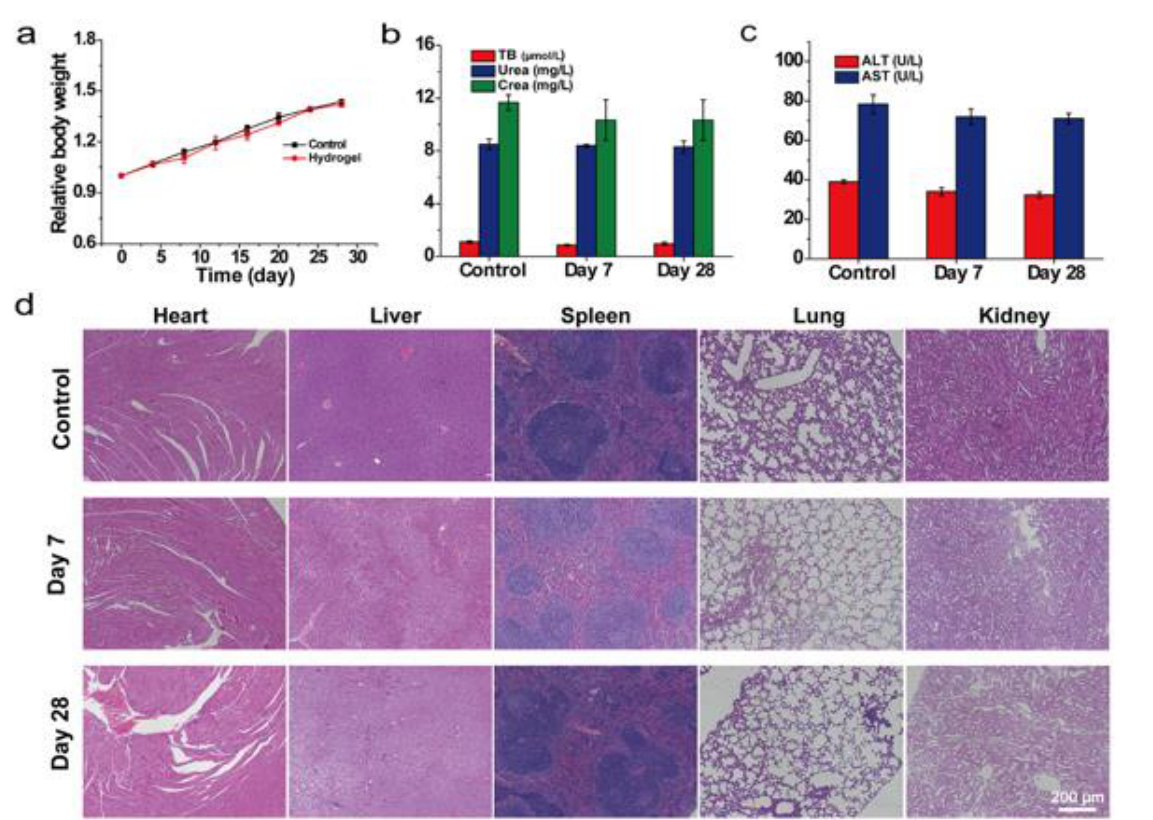
Figure 7. ( a ) Relative bodyweight of Kunming (KM) mice from different groups. ( b , c ) Blood biochemistry parameters of KM mice treated with or without chitosan/polyaniline/laponite (COL) hydrogels. ( d ) H&E staining of the major organs of KM mice treated with or without COL hydrogels.